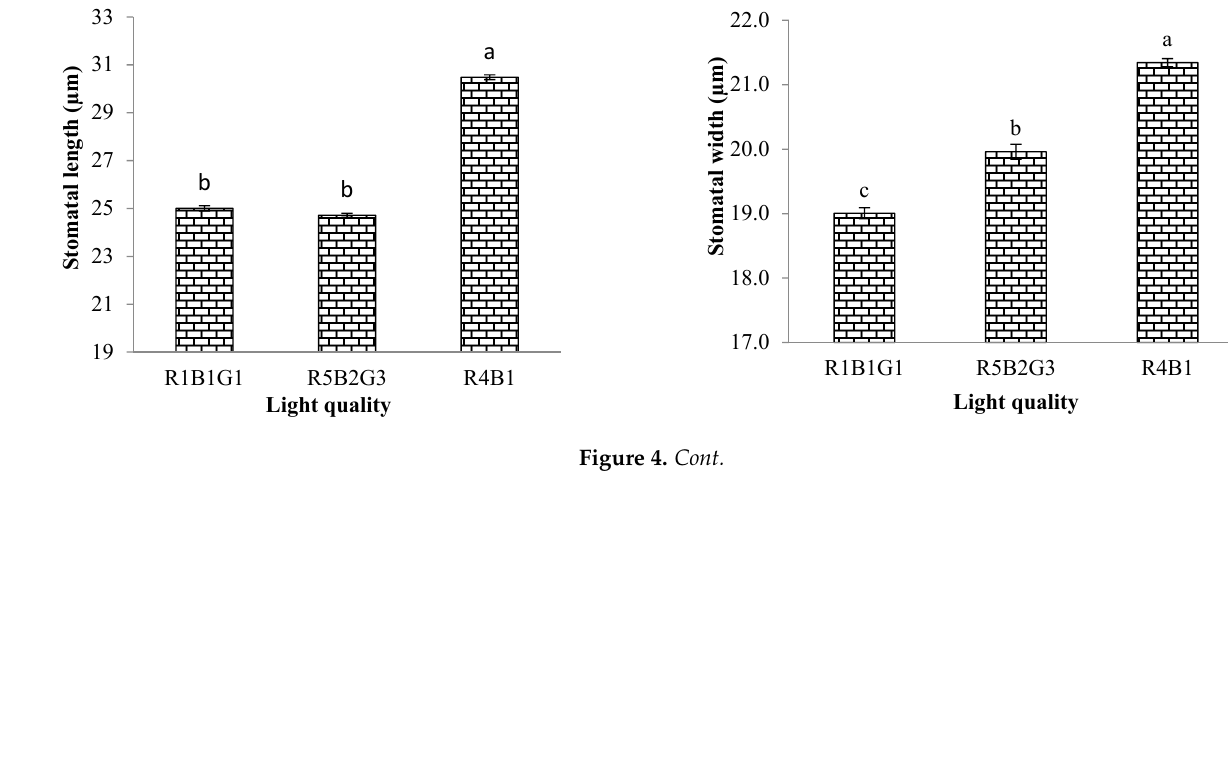
Figure 3. The adaxial epidermis of spinach leaves at different light qualities: ( a ) R4B1, ( b ) R5B2G3 and ( c ) R1B1G1. Scale bar is 50 µm.